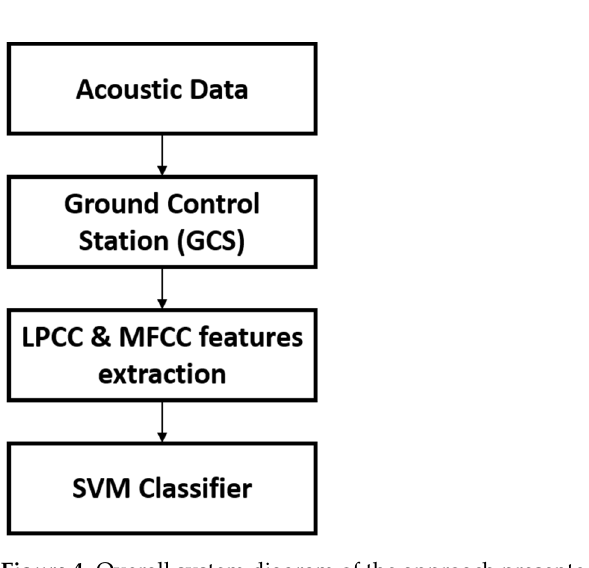
Figure 4. Overall system diagram of the approach presented in [38] .